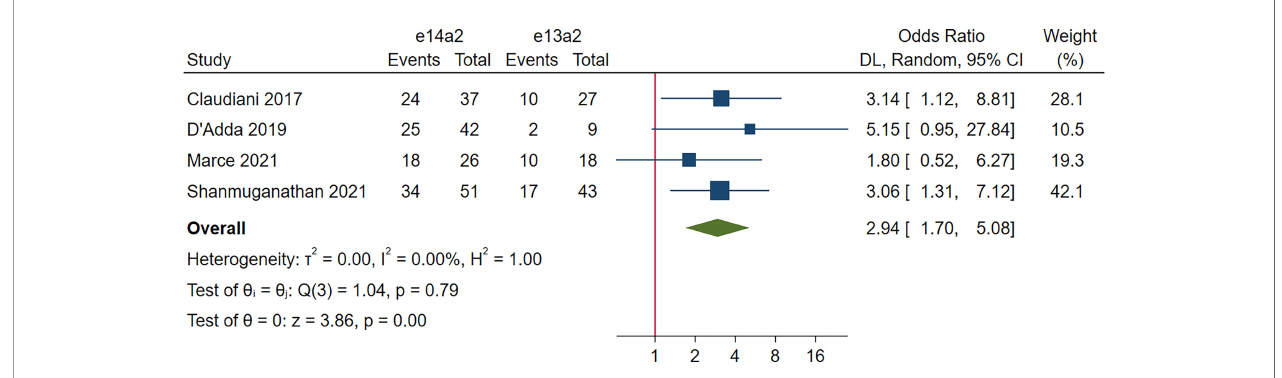
TABLE 2 | SUCRA results of evaluated outcomes for each transcript type.